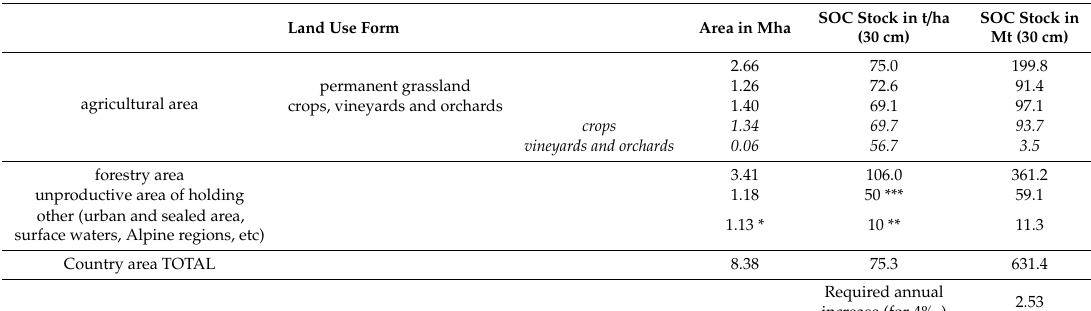
Table 3. Area and soil organic carbon (SOC) stocks of di ff erent Austrian land use forms. (*. calculated by di ff erence of total Austrian land area and the other land use forms; **. estimated for “other” (see Section 2.2.5); ***. estimated for the unproductive area of holding (see Section 2.2.5)). / ha Land Use Form Area in Mha SOC Stock in t (30